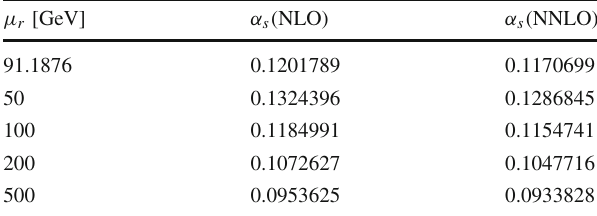
Table 1 Two-loop and three-loop running of α s (μ 2 r